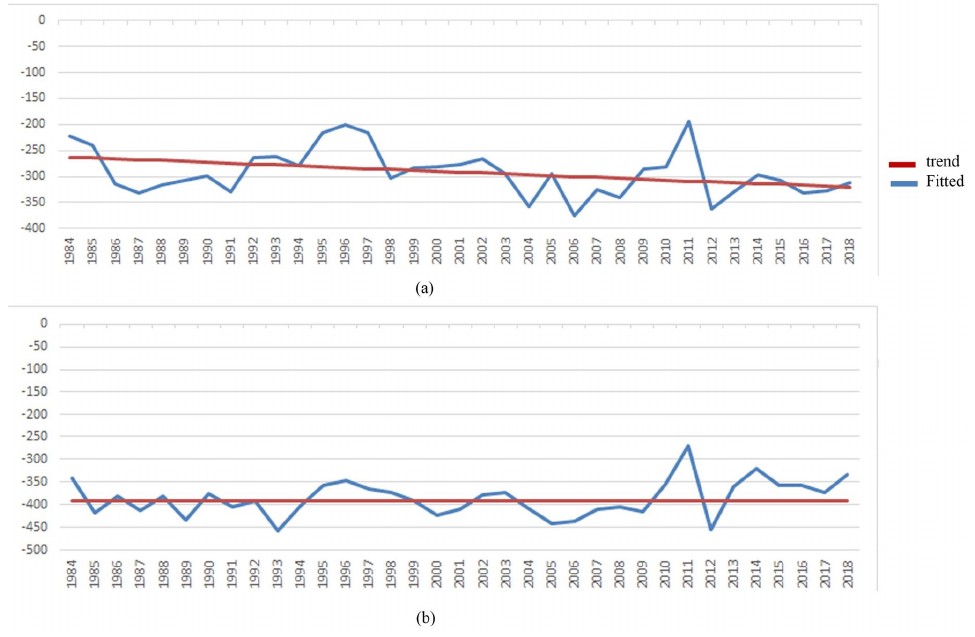
Figure 9. Annual composite of chosen class from 1984 to 2018. ( a ) A TCA trajectory of the formal area. ( b ) A TCA trajectory of an informal settlement representing changes.